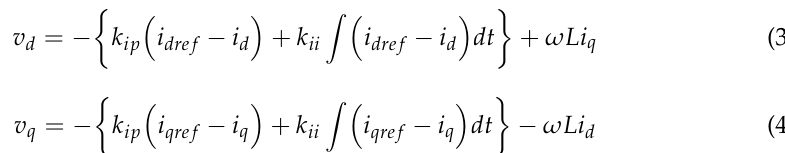
Figure 4. Control principles of energy storage DC ‐ AC converter.